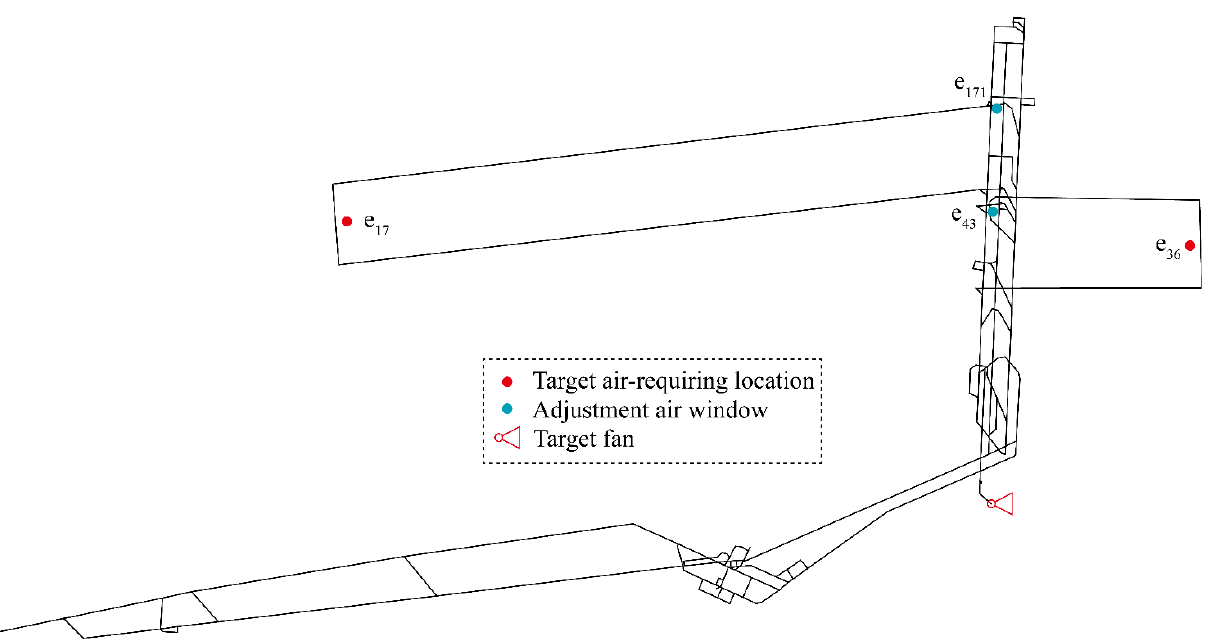
Figure 7. Ventilation system.